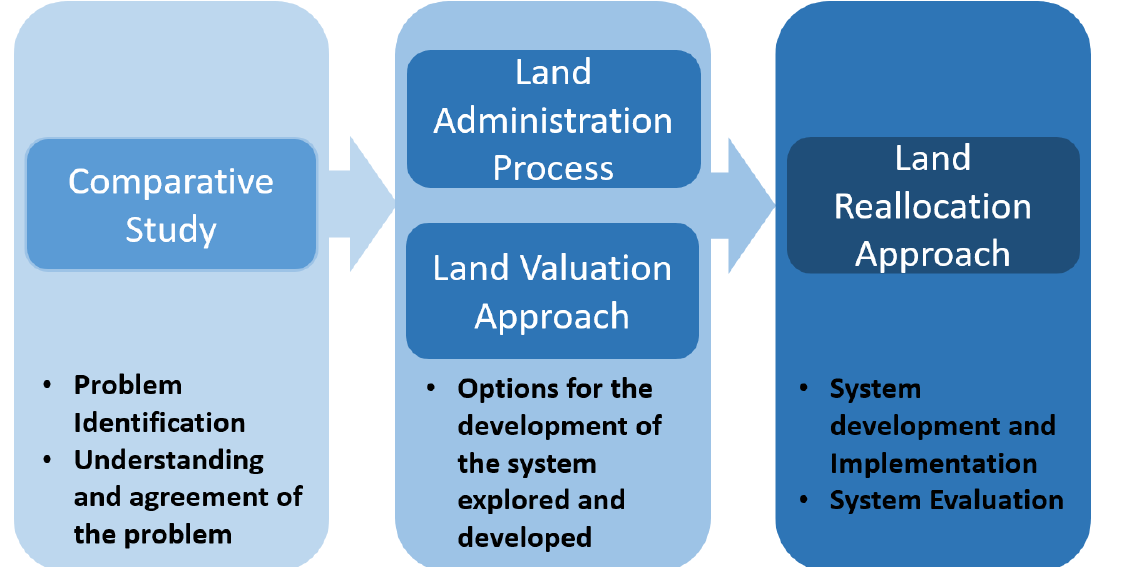
Figure 2. The design research Figure 2 . The design research approach.